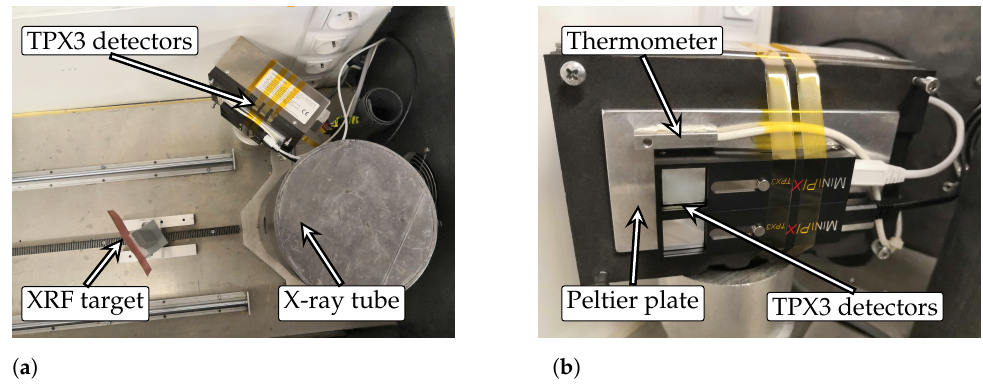
Figure 2. Detector arrangement for thermal testing of the Timepix3 detectors. ( a ) arrangement configuration for X-ray fluorescence measurement; ( b ) details of the detector placement on the Peltier module with feedback thermometer.